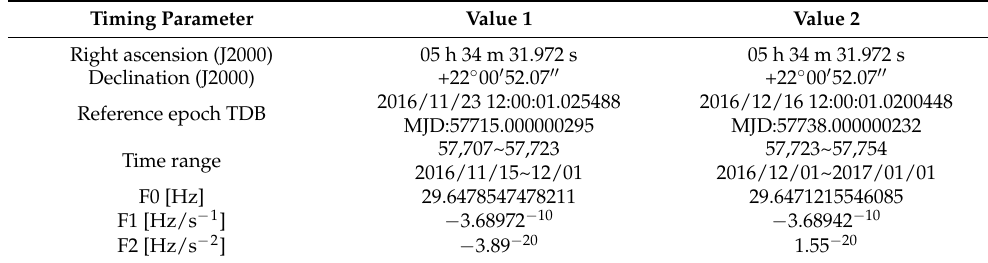
Table A3. Timing parameters of Crab